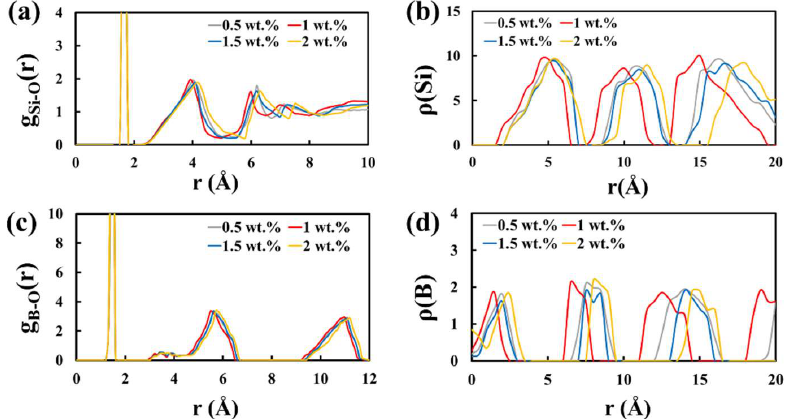
Figure 2. RDFs of ( a ) Si-O and ( c ) B-O, and NDPs of ( b ) Si and ( d ) B, at a representative direction of [1 1 1], of the foam glass samples with different amounts of carbon (0.5/1/1.5/2 wt.%) as foaming agent, under a sintering temperature of 780 °C.